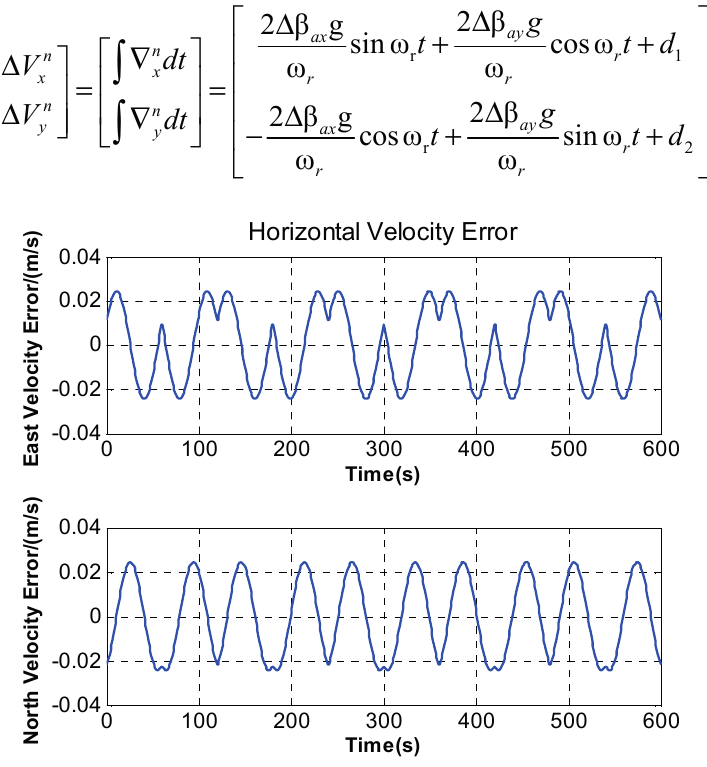
Figure 10. The simulation of the velocity fluctuation